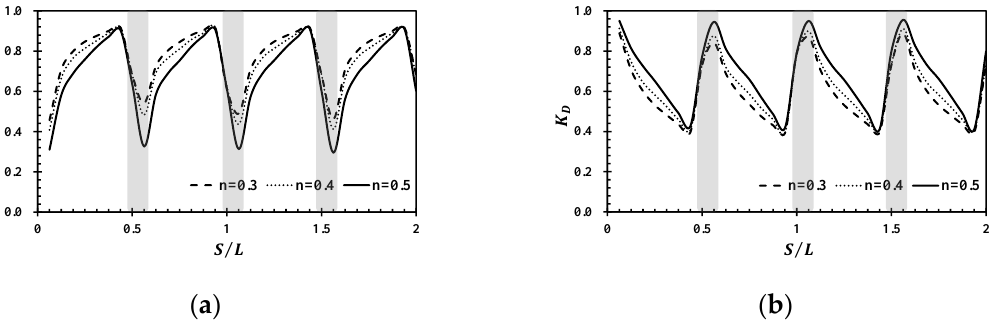
Figure 12. Variation of K R and K D for the different porosities of the submerged breakwaters ( m = 3 ) with kd = 0.6, ( a ) reflection coefficient K R . ( b ) dissipation coefficient K D .